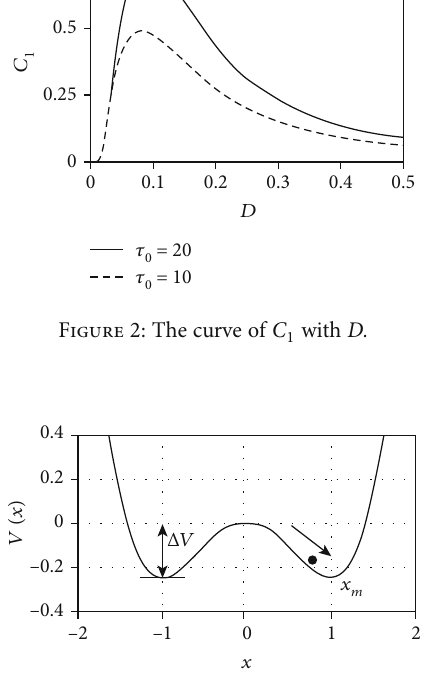
Figure 3: The bistable system potential well.